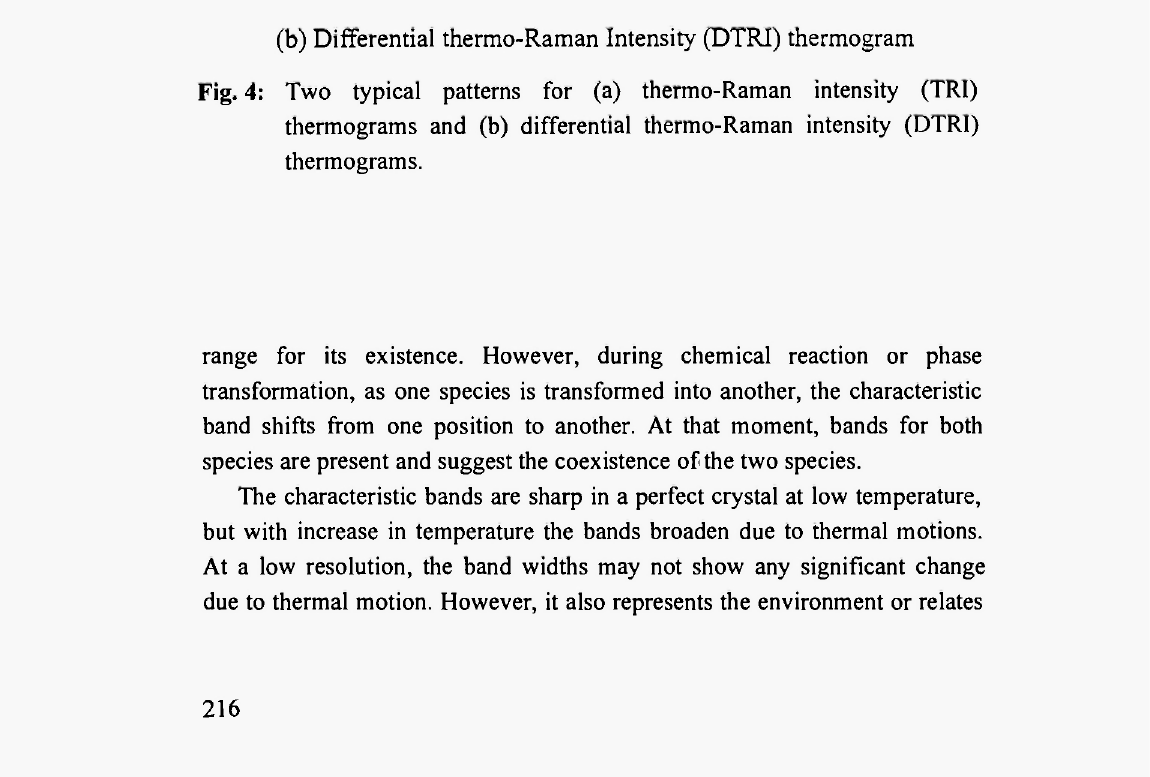
Fig. 4: Two typical patterns for (a) thermo-Raman intensity (TRI) thermograms and (b) differential thermo-Raman intensity (DTRI)